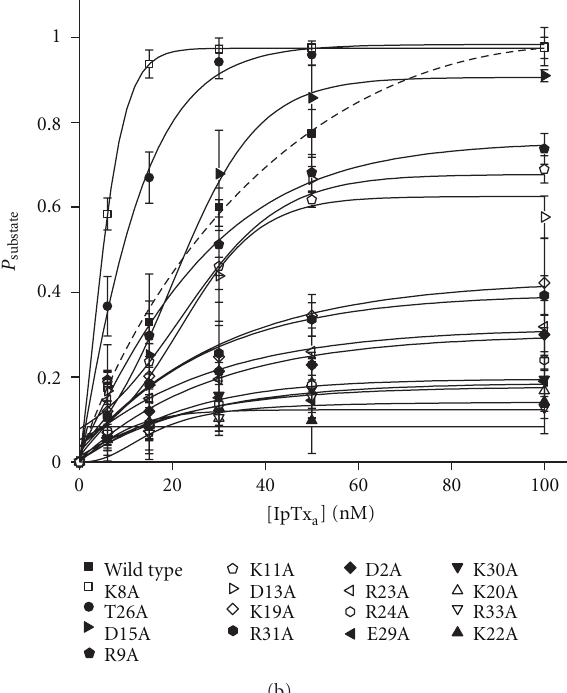
Figure 2: Single channel current traces of RyR1 modified by various alanine scanning IpTx a mutants. (a) Single channel current traces of skeletal RyR1 activated in the presence of 30nM wild-type or various mutant IpTx a ( cis side) at − 30 mV holding potential. Single channel opening is shown as a downward deflection. (b) The plots of P substate of RyR1 versus concentration of IpTx a are shown. The data points are means ± SE from 3–5 independent